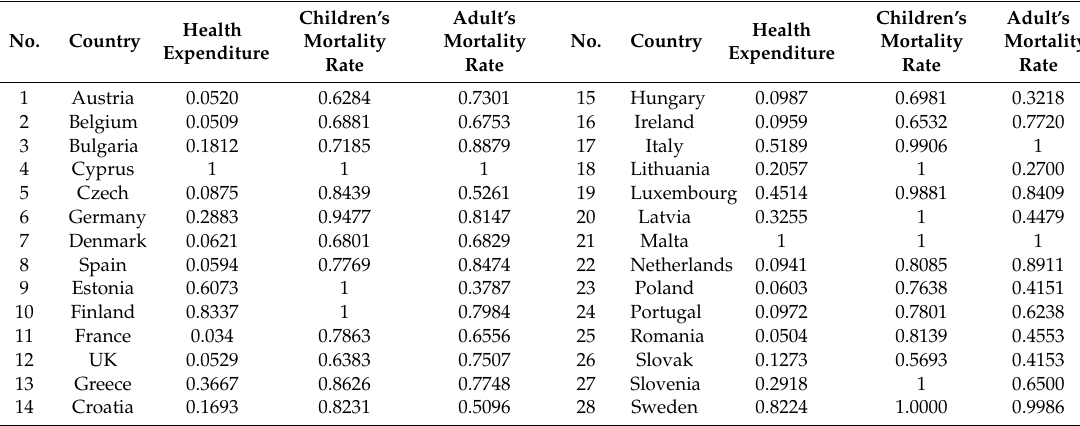
Table 11. Comparison of the annual health e ffi ciencies of EU countries from 2010 to